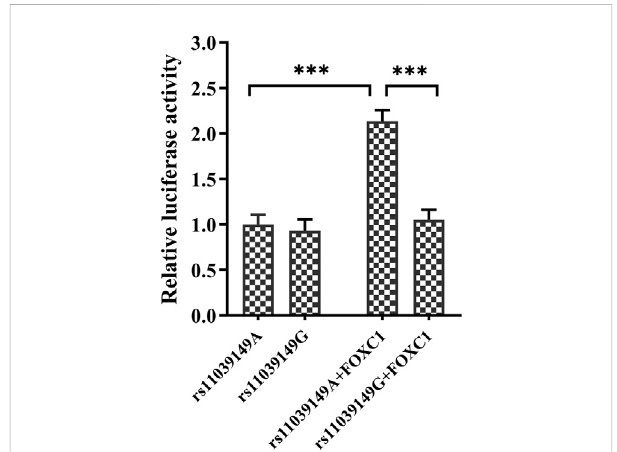
FIGURE 2 Transcription activity analysis of the NR1H3 promoter containing rs11039149A and rs11039149G alleles in HEK293T. After co- transfected with the FOXC1 gene, the wild pGL3-rs11039149A had a signi fi cantly higher relative luciferase activity by 2-fold than the mutant pGL3-rs11039149G (*** p < 0.001). The pGL3-rs11039149A and pGL3-rs11039149G luciferase reporter vectors carried the NR1H3 gene promoter fragment containing rs11039149A or rs11039149G allele, respectively. Fire fl y luciferase activity was expressed relative to pGL3-rs11039149A co-transfected with pENTER empty plasmid. Renilla luciferase activity encoded by the co-transfected control plasmid pRL-TK to standardize the transfection ef fi ciency. Data are presented as mean ± standard error (SE) from three independent